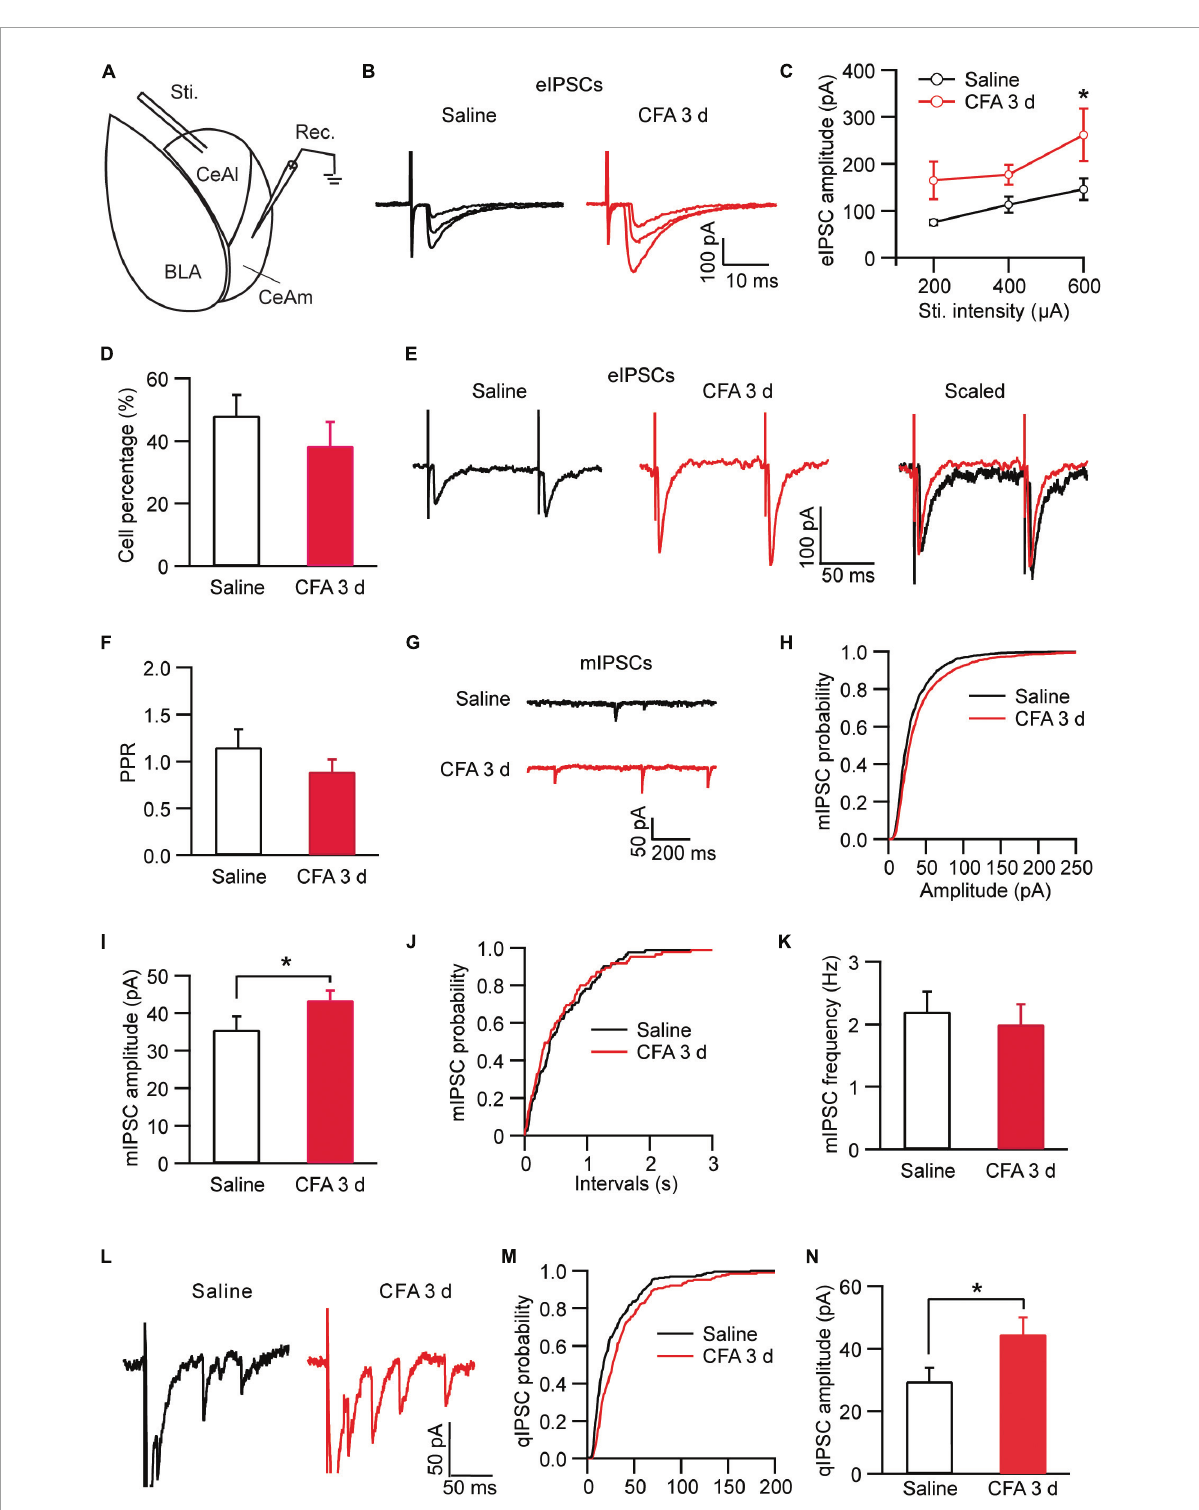
FIGURE3 Persistent pain activates the CeAl–CeAm pathway. (A) A schematic of recording configuration in amygdala with electrical stimulation in CeAl and whole-cell recording in CeAm. (B,C) Current traces (B) and group data (C) of evoked IPSCs (eIPSCs) in CeAm neurons with various stimulation intensities in the saline and CFA groups ( n = 4–25 per group). (D) Percentage of CeAm cells displaying CeAl-elicited eIPSCs in the two rat groups. (E , F) Current traces of eIPSC pairs (E) and group data of paired-pulse ratio (PPR, F ) in the two rat groups. (G–K) Representative traces of miniature IPSCs (mIPSCs, G ), group data of mIPSC amplitude (H,I) and mIPSC frequency (J,K) in the saline and CFA groups. (L) Representative current traces of an evoked IPSC (truncated) followed by quantal IPSCs (qIPSCs) from a rat in the saline and CFA groups. (M,N) Cumulative probability (M) and group data (N) of qIPSC amplitude in the saline and CFA groups of rats. * p <